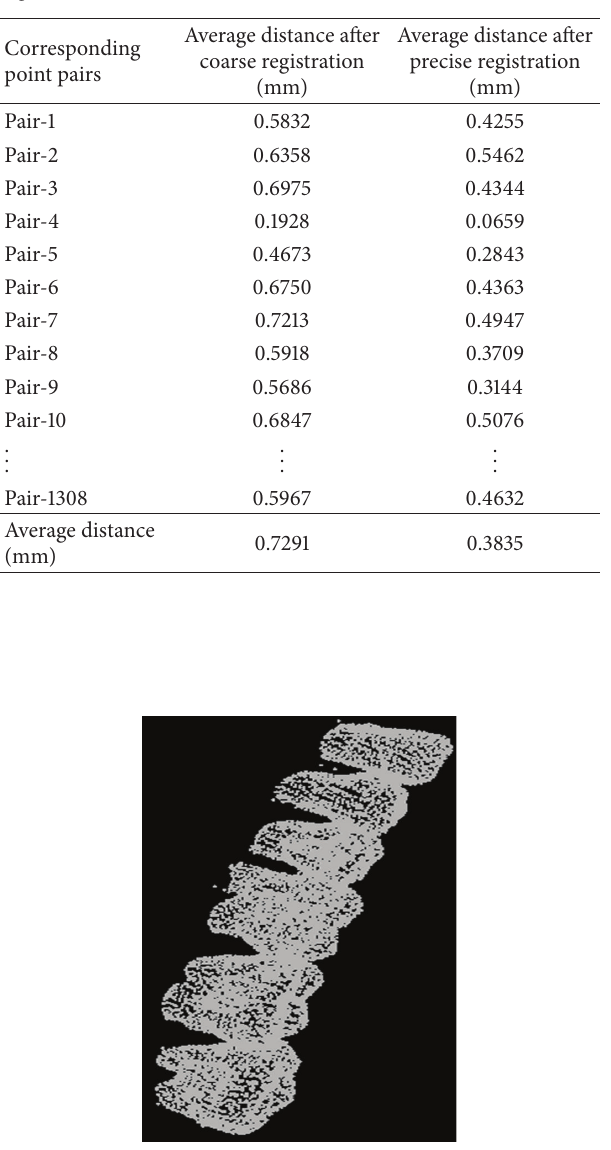
Table 2: Compared results on the coarse registration and precise registration.